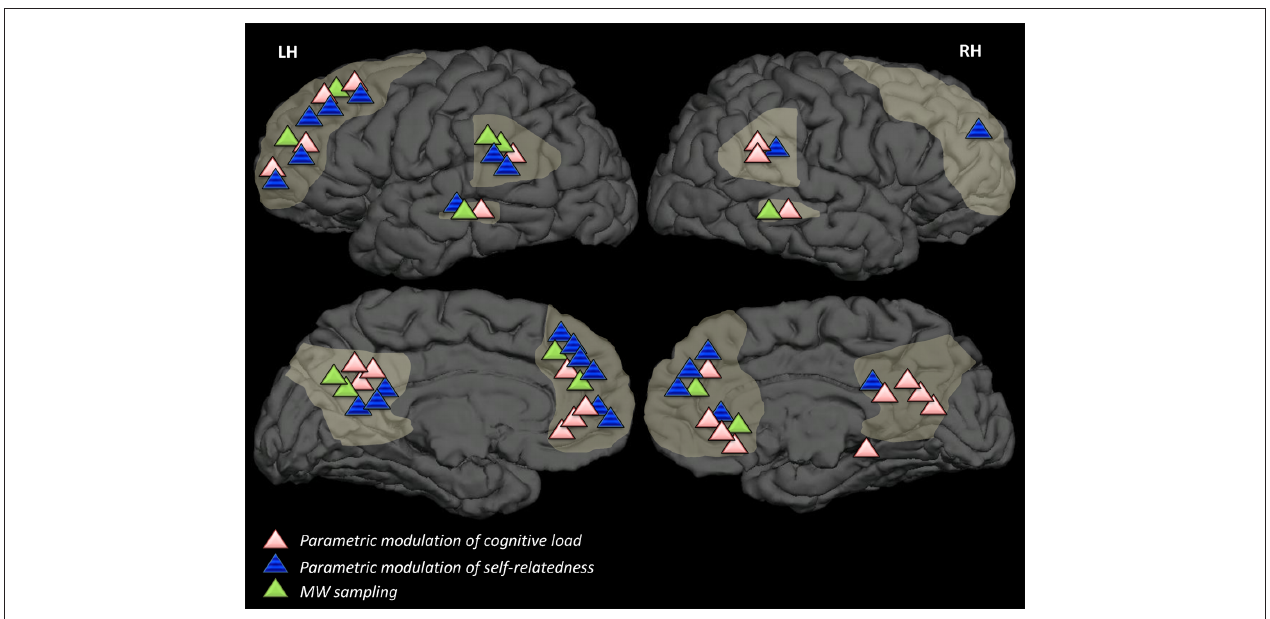
lateral temporal cortices, precuneus, and posterior cingulate cortex. Strategies which have not been employed in neuroimaging studies (strategy A2) or strategies which are concerned with degree of connectivity rather than degree of activation in brain areas (strategy B3) are not represented in this